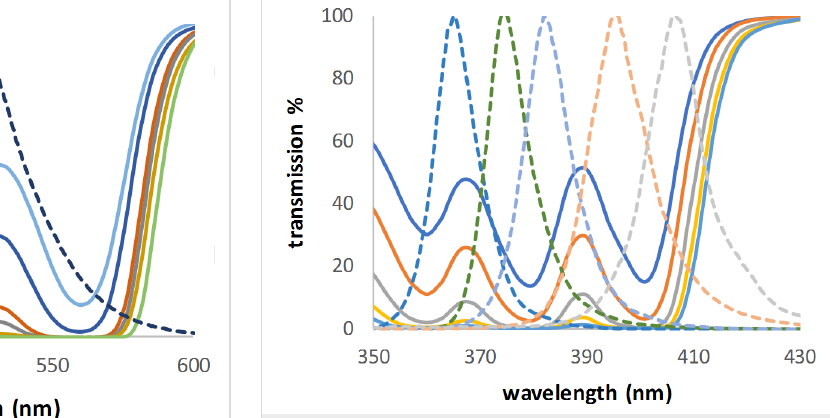
Figure 5: Transmission spectra of dimethylanthracene ( Gb ) and emis- sion spectra of LEDs with maxima at 365, 375, 383, 394, and 407 nm, respectively (all scaled to